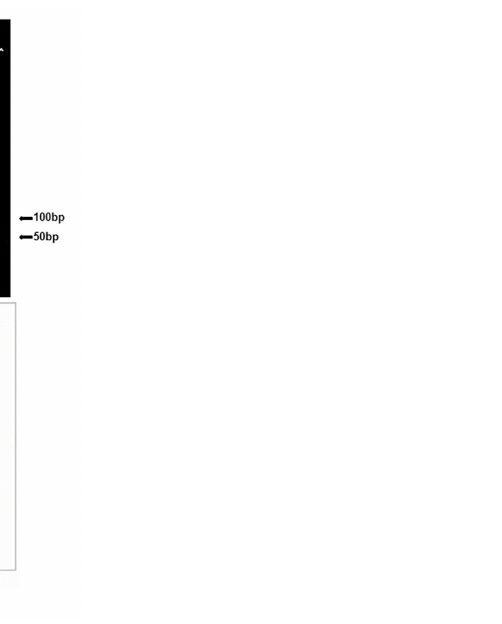
Figure 2. PCR and qPCR with ‘Hongyingzi’ as standard substance amplified by wxc F4. ( A ) Elec- trophoretic analysis of ‘Hongyingzi’ with ten-fold serially diluted from 100.0 ng to 1.0 pg; ( B ) the relationship between logarithm of the amount of ‘Hongyingzi’ and the value of CT.